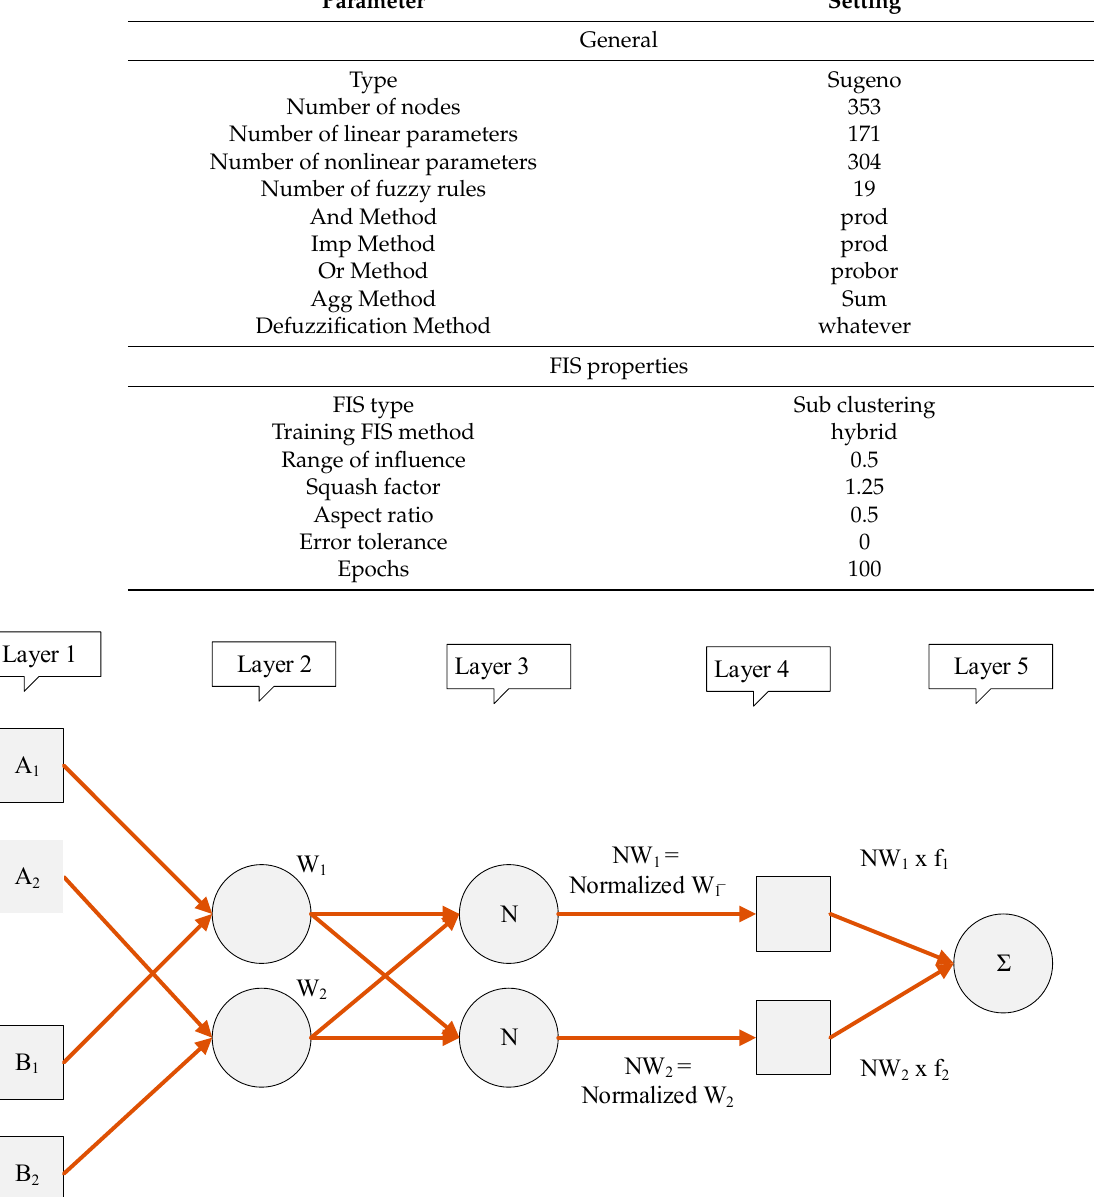
Figure 2. Typical architecture of the ANFIS algorithm. Table 3. Setting hyperparameters for the ANFIS model.